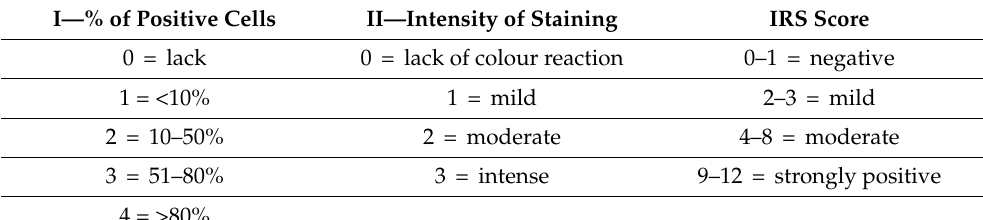
Table 2. Immunoreactive score—IRS [47].